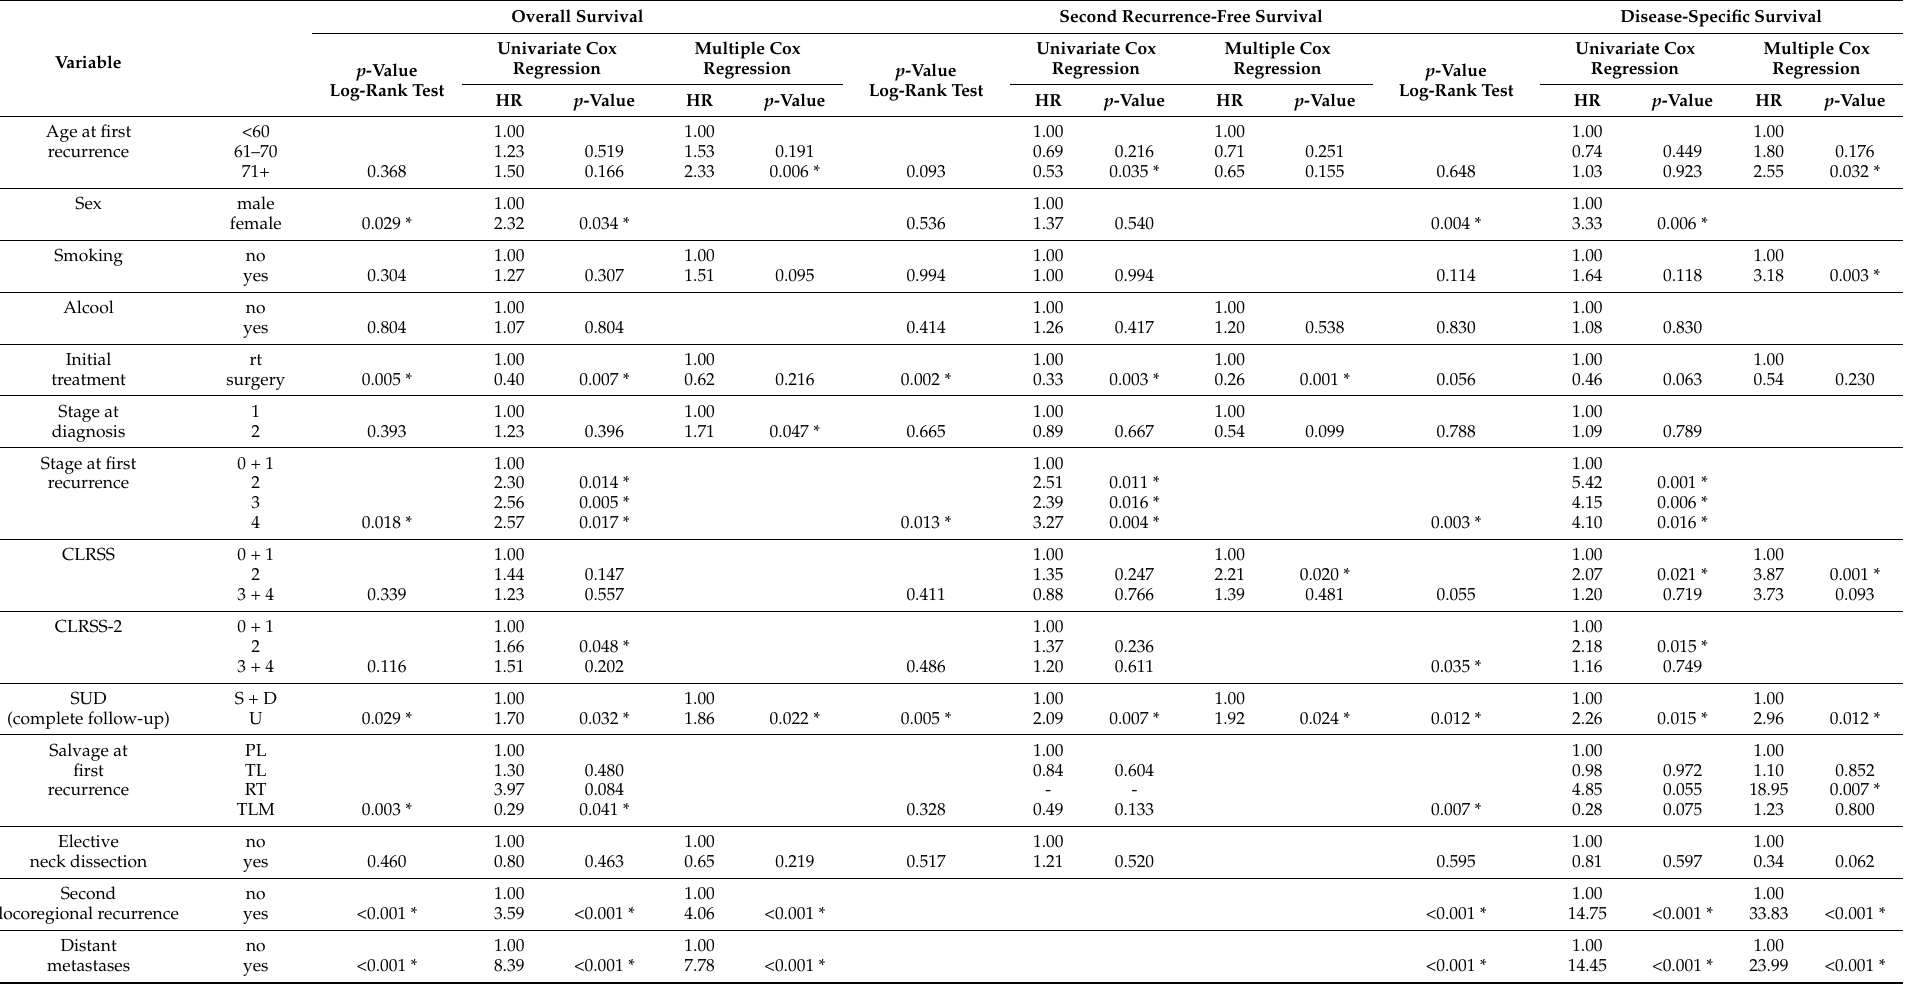
Table 2. Log-rank test, along with univariate and bivariate Cox regression analyses, for overall survival, second-recurrence-free survival, and disease-specific survival for each considered factor; * denotes a p -value < 0.05. Acronyms: S = same-stage; U = up-stage; D = down-stage; PL = partial laryngectomy; TL =